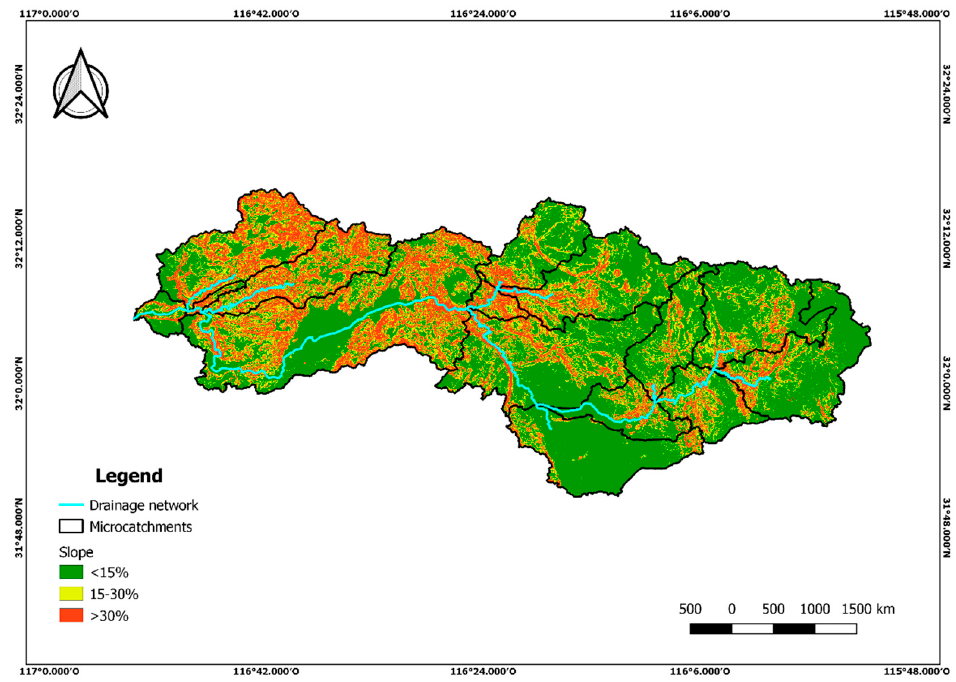
Figure 4. Slope Classification Map.